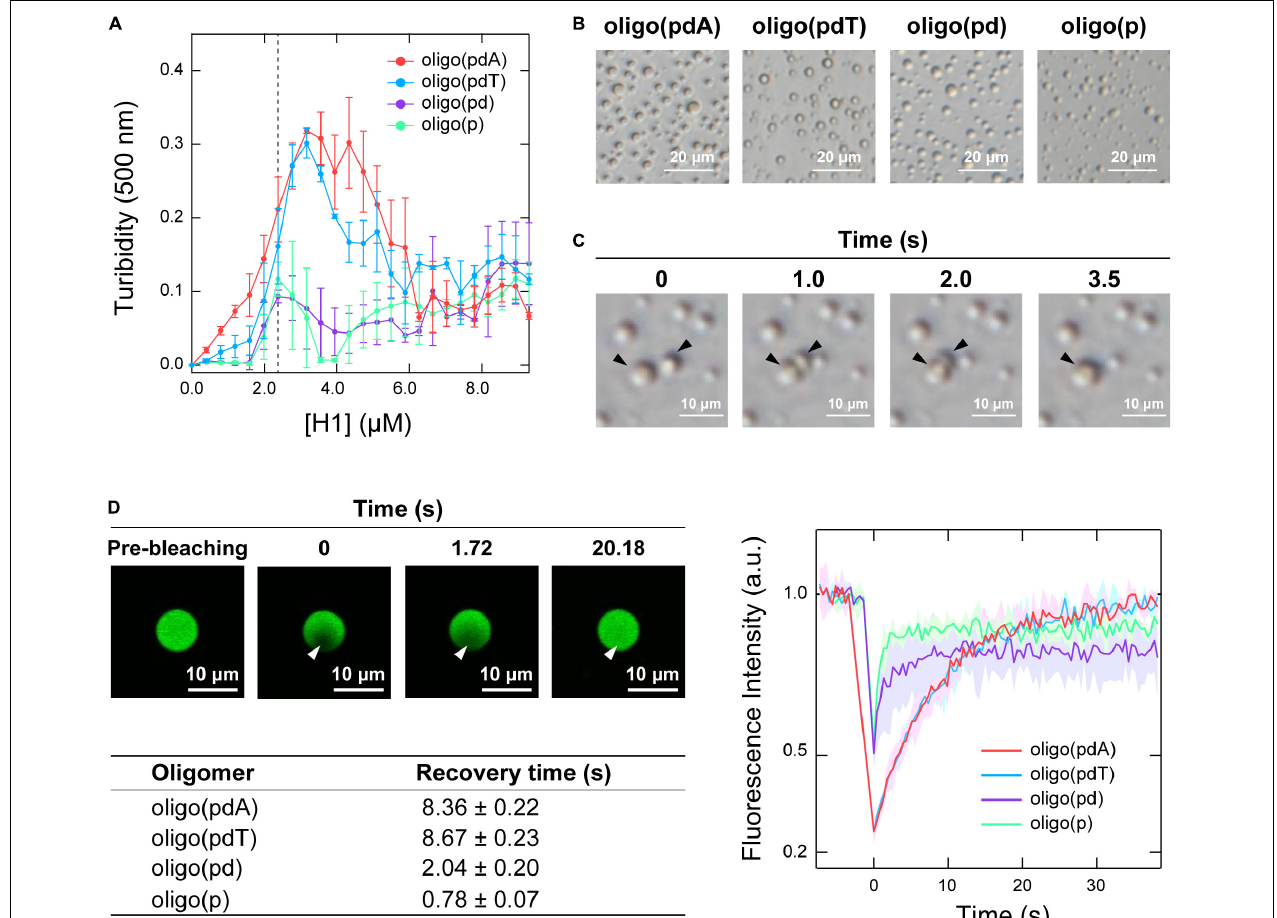
FIGURE 2 | LLPS of mixtures of the oligomers and H1. (A) Turbidimetric titration curves of H1 against solutions containing 5.0 µ M of the oligomers. (B) Phase-contrast microscopy images of the solutions under the conditions indicated by the dotted line in panel A (5.0 µ M oligomer and 2.5 µ M H1); scale bar = 20 µ m. (C) Fusion process of the spherical assemblies formed by oligo(pdA) (5.0 µ M) and H1 (2.5 µ M); scale bar = 10 µ m. (D) Left: confocal fluorescence microscopy images during FRAP measurements. White arrowhead indicates the bleached area; scale bar = 10 µ m. Right: FRAP recovery curves for the oligomers; values shown represent mean values ± standard deviation ( n = 3). The table below lists the fluorescence-recovery times calculated by single-exponential fitting. All experiments were carried out in 10 mM Tris-EDTA buffer (pH =